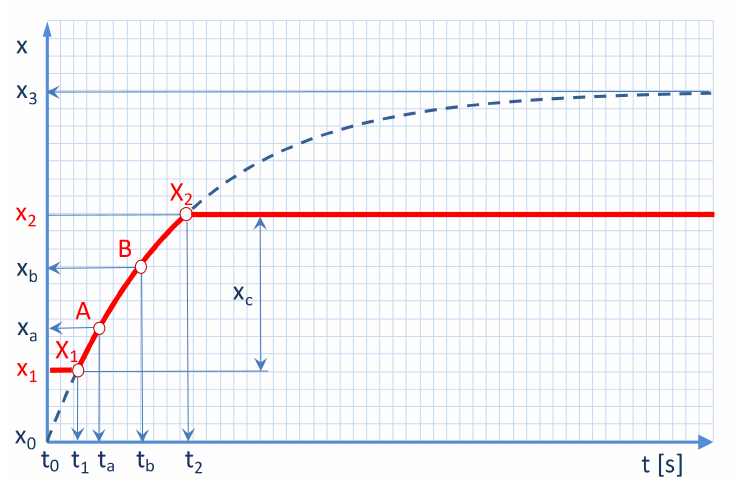
Figure 6. Illustration of the characteristic points useful for the